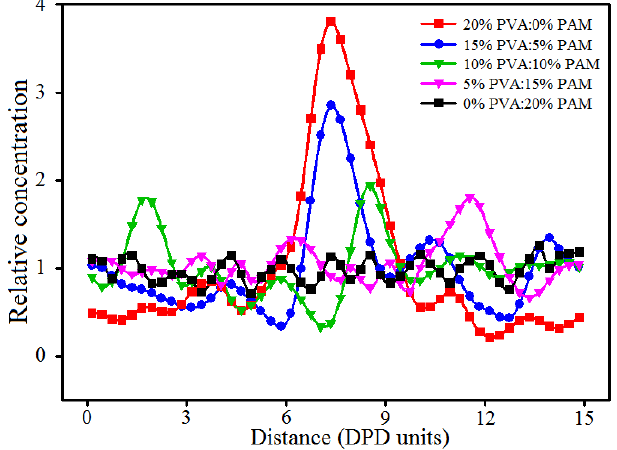
Figure 10. Relative concentration distribution functions of nano-silica in PVA/PAM/1.5% nano-silica blended hydrogels with different polymer component ratios.